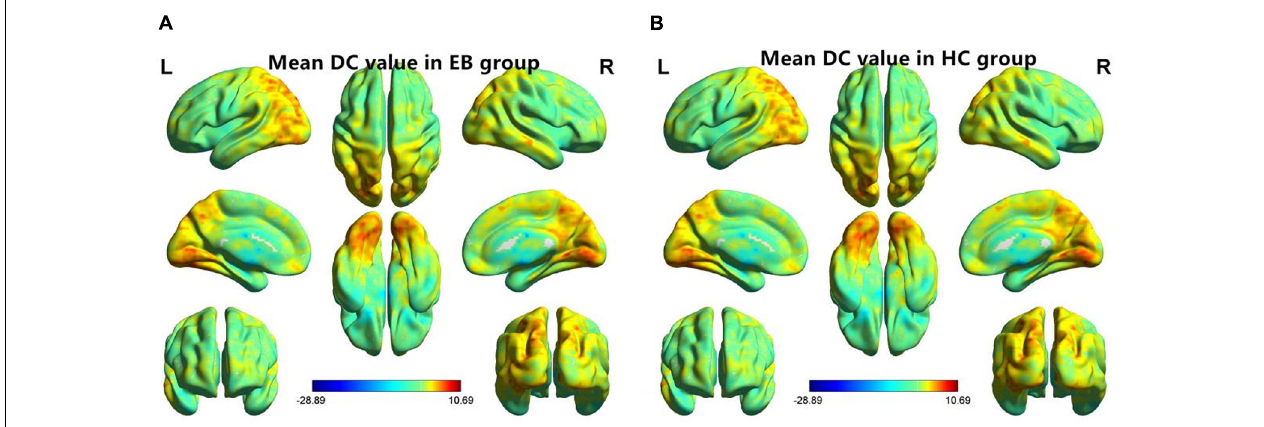
FIGURE 1 | One-sample t -test results of maps in the (A) EB group and the (B) SC group. DC, degree centrality; EB, early blindness; SCs, sighted controls; L, left; and R, right.